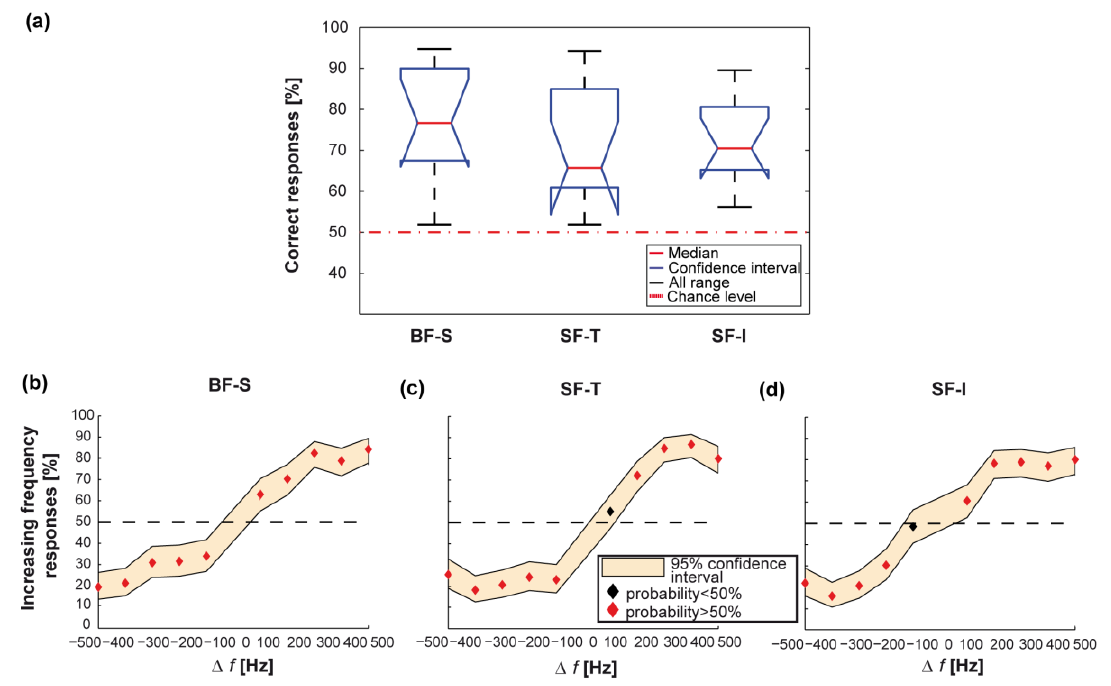
Figure 10. Stimuli perception with single-finger configuration . ( a ) Comparison between the fraction of correct responses (i.e., increasing frequency variations identified as increasing or decreasing frequency variations identified as decreasing) in all three configurations. Boxes represent the interquartile range and black dashed lines show the complete range across participants; ( b ) psychometric curve for the BF-S stimulation configuration. Each dot represents the fraction of times each stimulus was classified as having an increasing frequency (median across participants). If the identification rate is significantly different (average > 50%, binofit test) from chance the dot is red, otherwise, it is black. The filled area indicates the 95% confidence interval (binofit test) across participants and the black horizontal dashed line represents chance; ( c ) the same as (b) for the SF-T stimulation configuration; and ( d ) the same as (b) for the SF-I stimulation configuration.